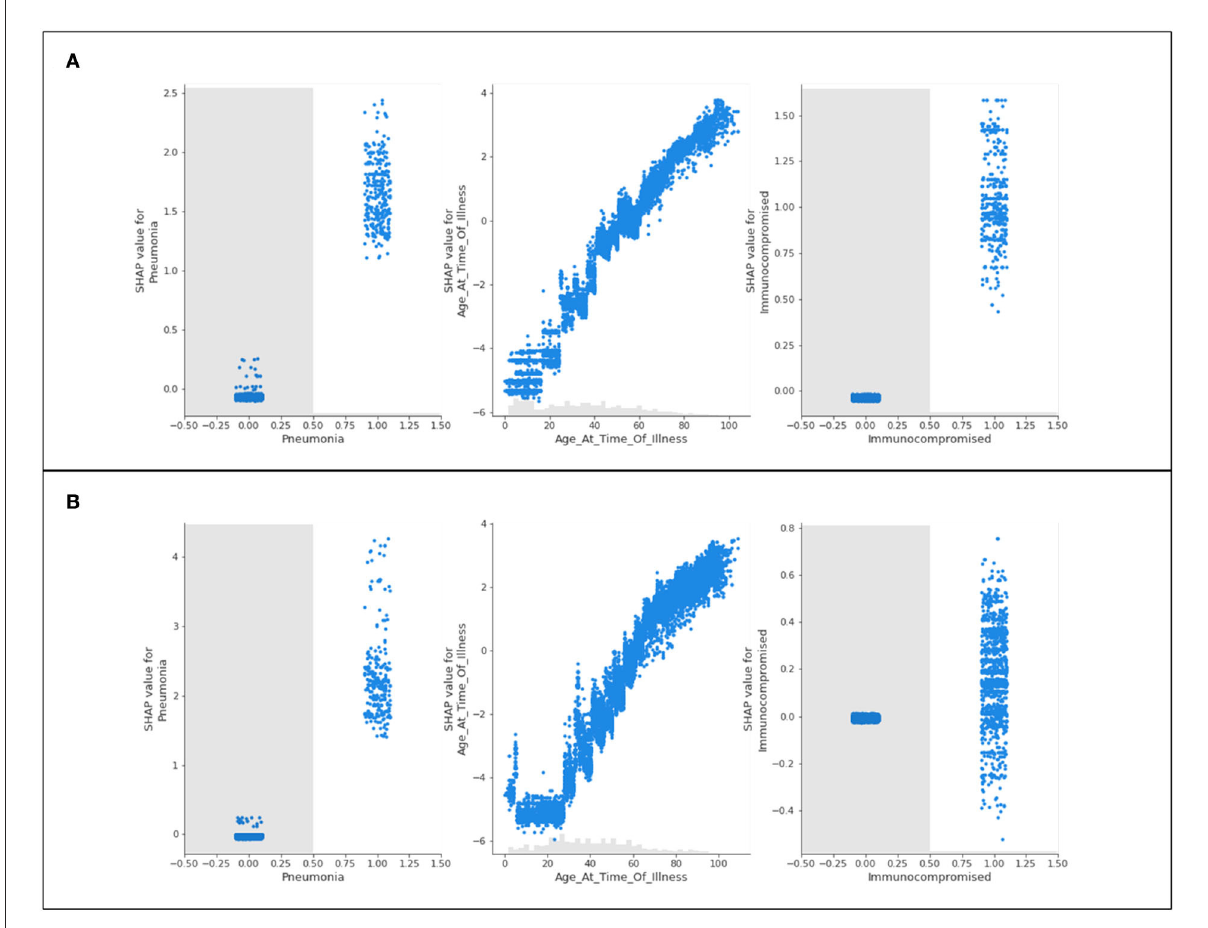
FIGURE9 Scatter plots of three features of concern (pneumonia, age, and immunocompromised) for (A) Delta- and (B) Omicron- related death